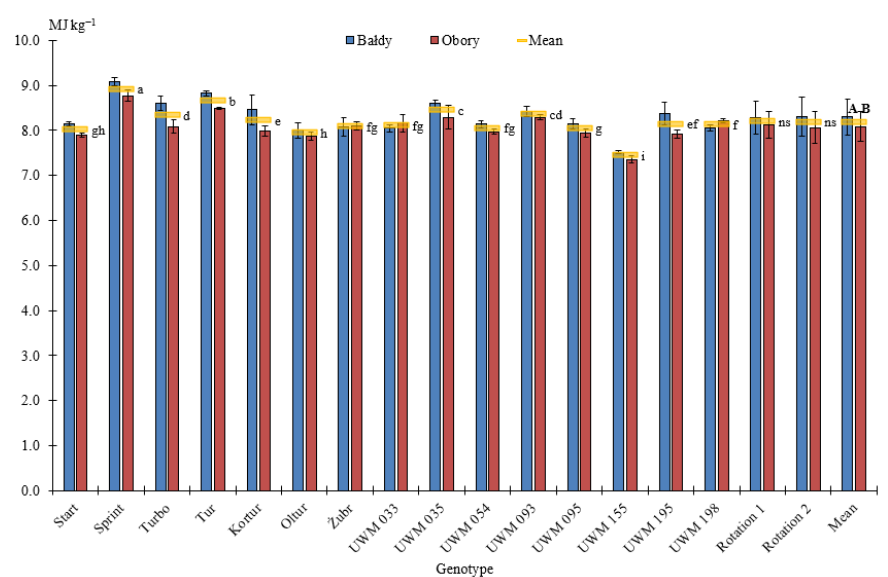
Figure 5. Higher heating value (HHV) of the biomass of 15 willow genotypes obtained at two locations in two consecutive three-year harvest rotations; (legend: see Figure 1).